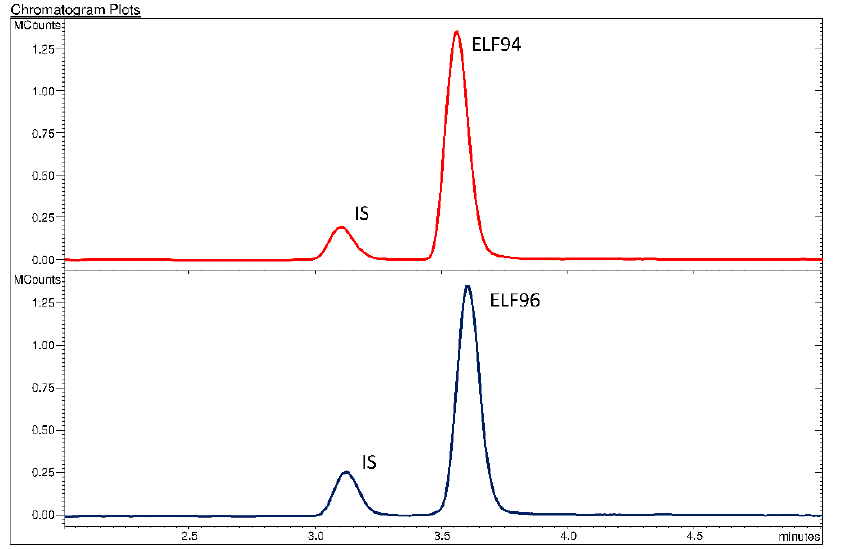
Figure 2. Chromatographic profiles of the HPLC-MS/MS analysis of the ELF94 and ELF96 isomers. 121